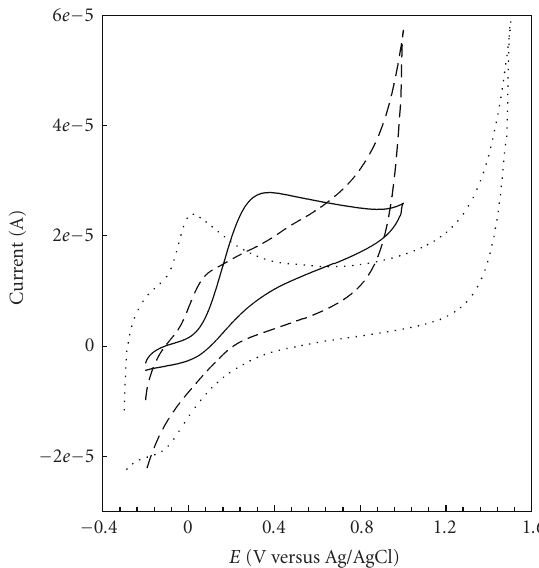
Figure 5: Cyclic voltammograms of 1mM AA in phosphate bu ff er solution of pH 7.0 on the surface of various electrodes; bare GCE (solid line), CNT-GCE (dotted line), and oppy/MWCNT/GCE (dashed line). Potential sweep rate was 100 mVs − 1 .